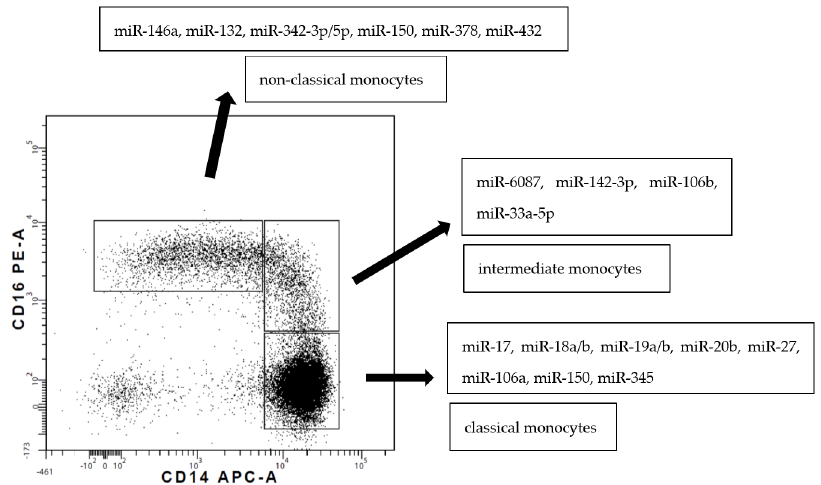
Figure 2. A dot plot representing three subsets of human monocytes according to the expression of CD14 and CD16 supplemented with data concerning upregulated miRNA